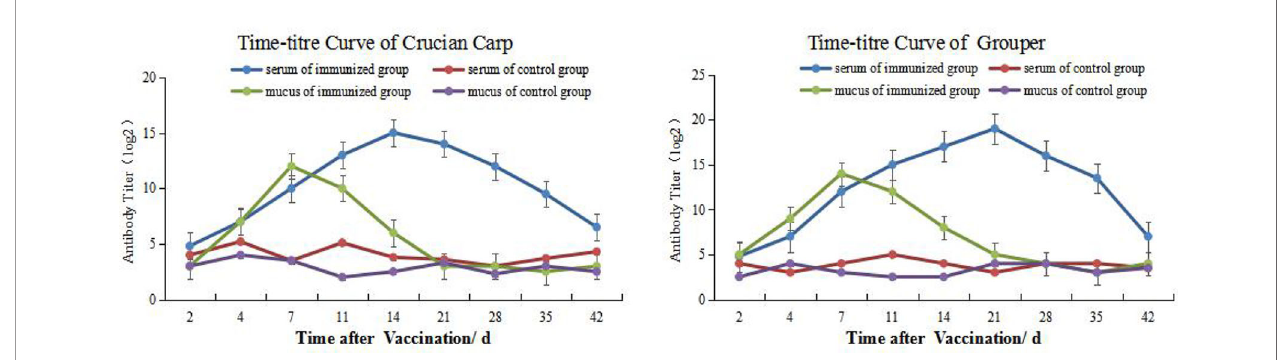
FIGURE 1 | Time-and antibody titers of Carassius auratus (left) and Epinephelus coioides